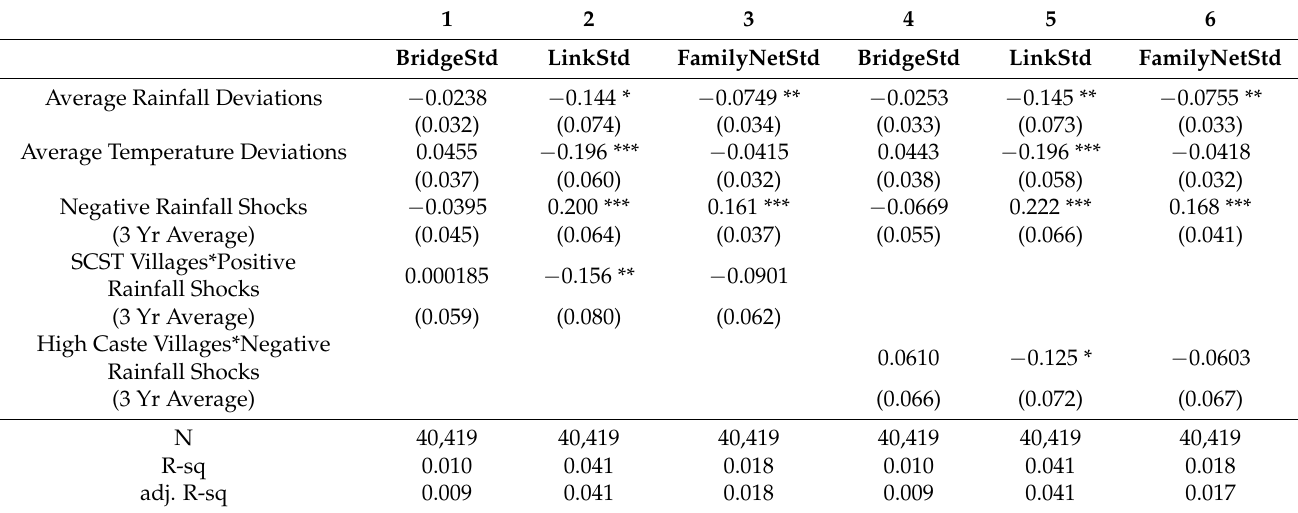
Table A2. Results assessing the impacts of the average climate shocks on social networks among high-income villages.